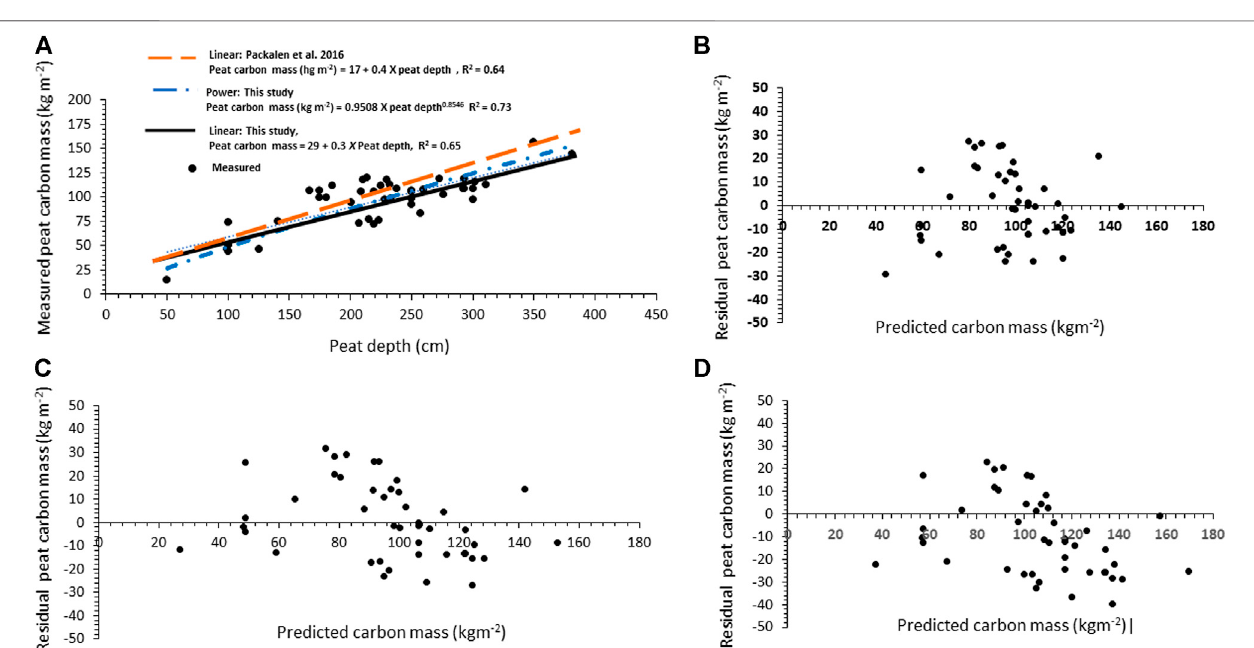
FIGURE8| Peatcarbonmasscalculationsbasedon44peatpro fi lessampledinthe74,300 km 2 studyareainthesouthernHudsonBayLowlands,Canada,for (A) peat depth vs. measured carbon mass for three regression equations, (B) measured – predicted residual carbon mass for (B) linear, (C) power, and (D) Packalen et al. (2016) regression